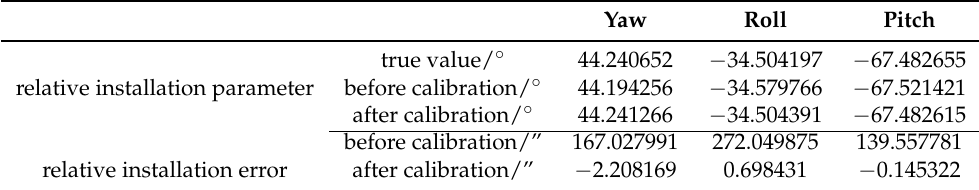
Table 6. The relative installation error from star sensor A to star sensor B.